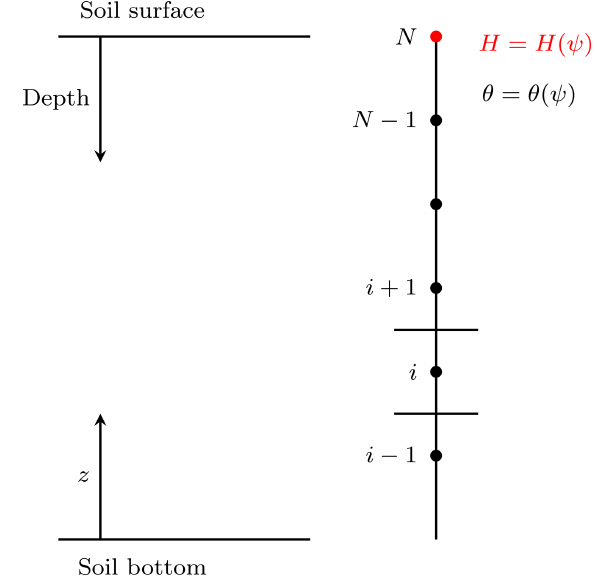
Figure 1. Scheme of the computational domain to solve the R 2 equation in 1D. The uppermost node represents the water depth at the soil surface. By considering this additional computational node the boundary condition does not change its nature depending on the